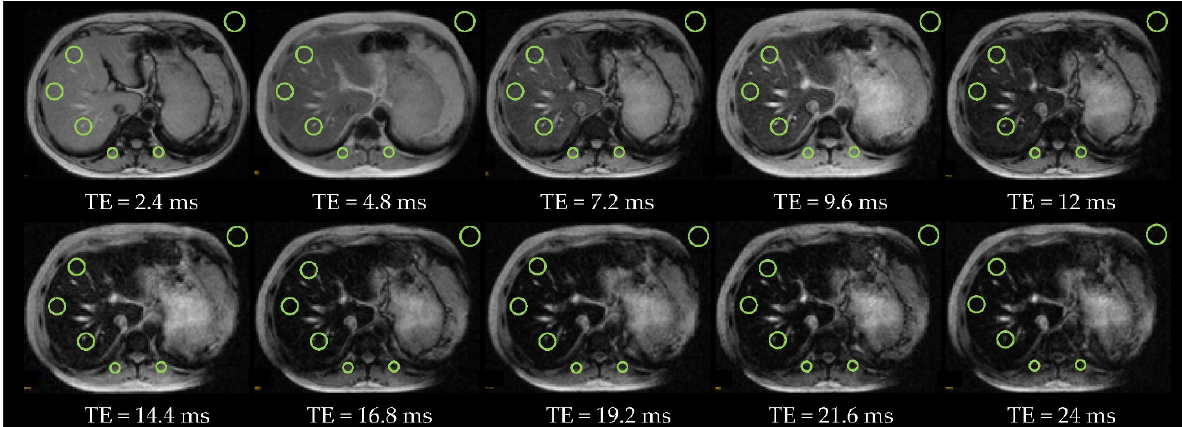
Figure 9. Patient #5 with severe iron overload and moderate steatosis at 1.5T ( T2 * = 6.2 ms and LIC = 95 µmol/g). There are 10 echoes with a duration of 2.4 ms each echo. The OOP images are with TE = 2.4 ms, 7.2 ms, 12 ms, 16.8 ms, and 21.6 ms and IP images are with TE = 4.8 ms, 9.6 ms, 14.4 ms, 19.2 ms, and 24 ms. There are 3 ROIs in the liver, 2 ROIs in paravertebral muscles, and 1 ROI of background noise.